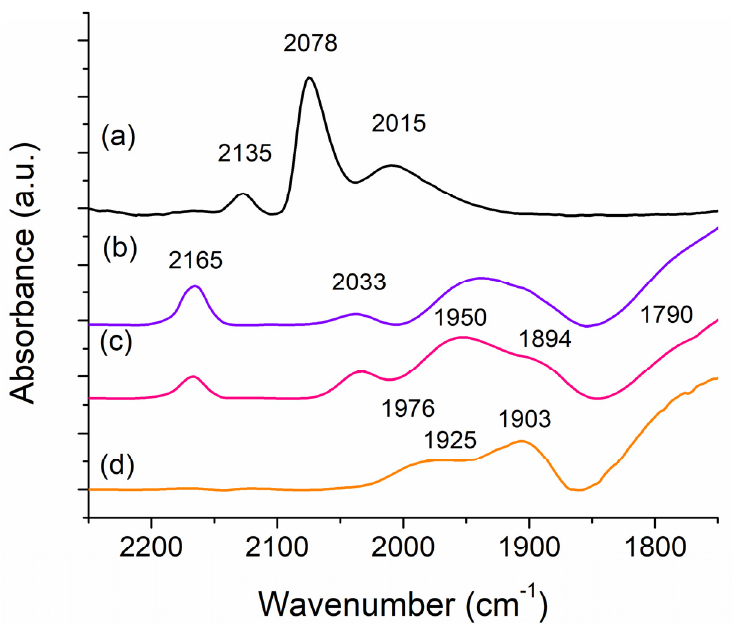
Figure 8. FT-IR spectra of CO adsorption on ( a ) 4 Ru ( b ) 4,12 RuK ( c ) 1,3,12 RuSrK and ( d ) 1,3,12 RuFeK.